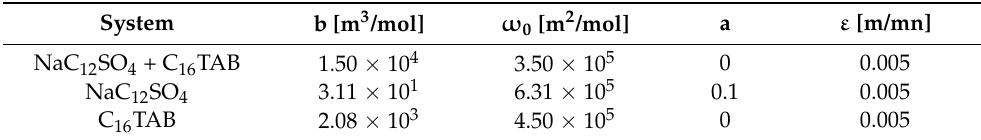
Figure 3. Equilibrium interfacial tension measured by profile analysis tensiometry (PAT) at the solution/hexane interface as a function of the total bulk concentration c of the mixtures ( (cid:7) ) NaC 12 SO 4 + C 16 TAB and the individual surfactants ( (cid:4) ) NaC 12 SO 4 and ( ) C 16 TAB; the solid lines are the fitting results for a Frumkin adsorption model given by Equations (1)–(3). Table 3. Parameter values obtained by fitting the Frumkin adsorption model Equations (1)–(3) to the experimental data of Figure 3.